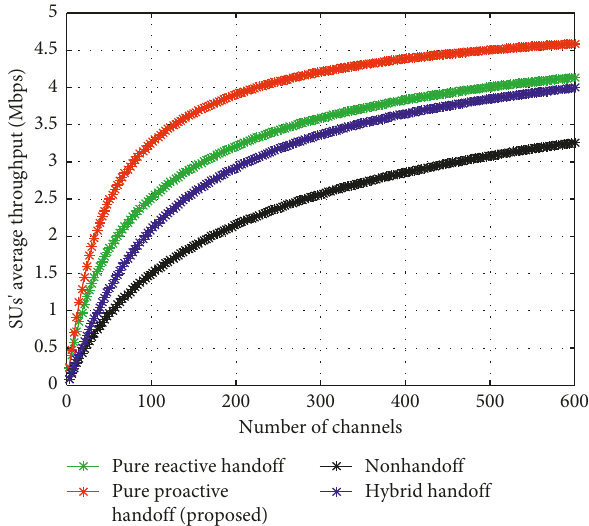
Figure 12: Illustration of performance in terms of throughput versus length of a transmission.